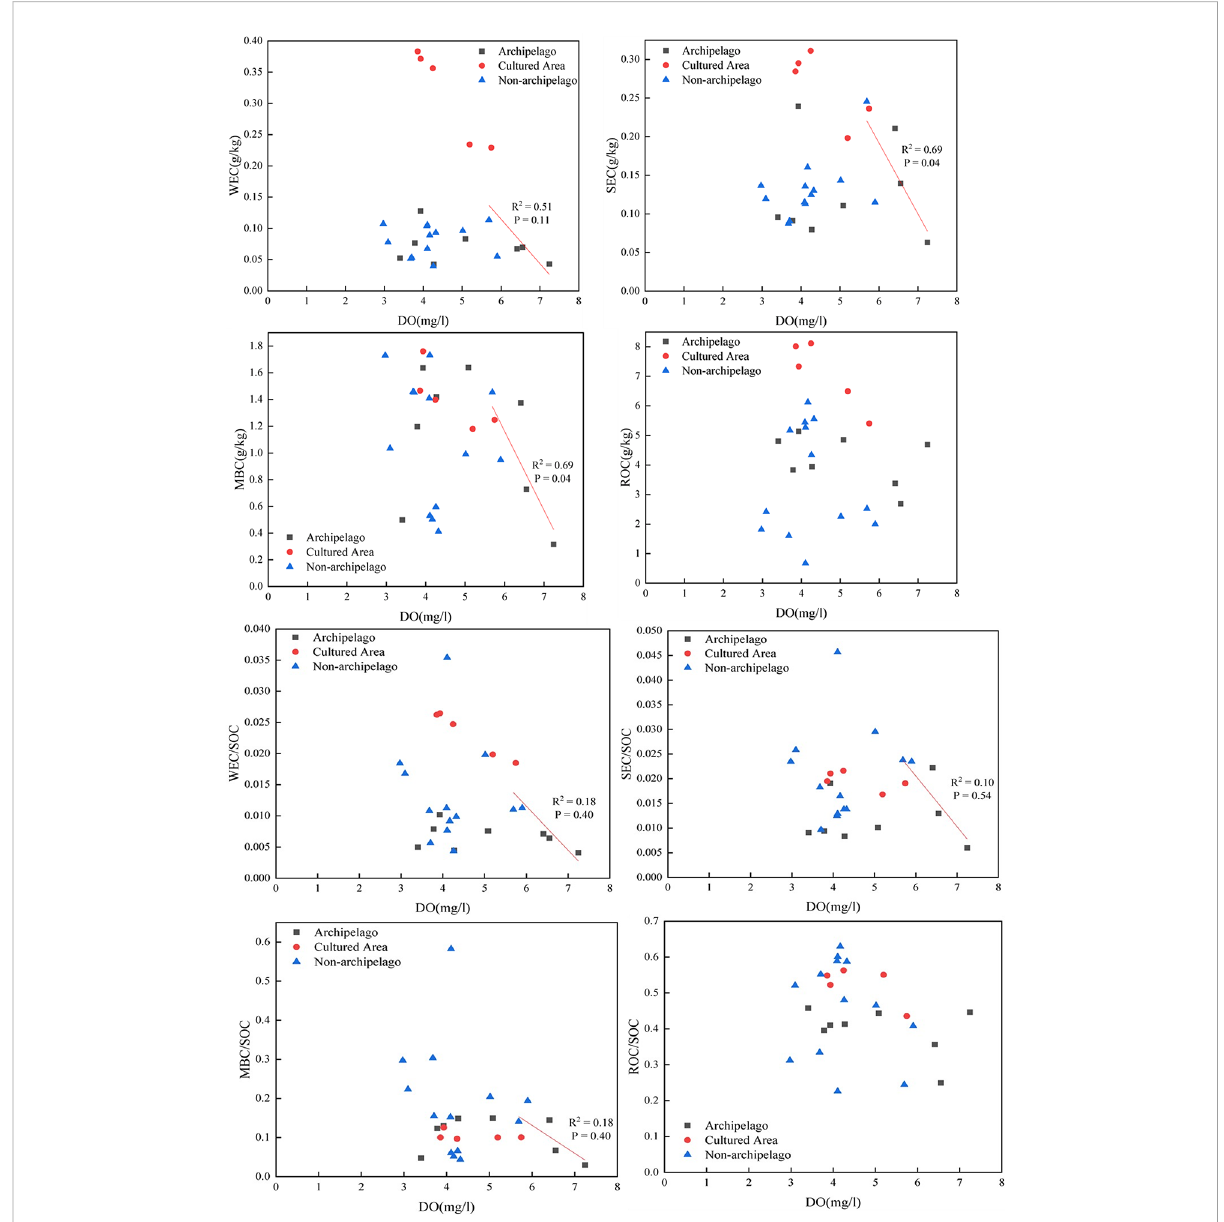
FIGURE 6 Relationship between various carbon fractions in the surface sediments and dissolved oxygen in the near-bottom waters. Gray and dashed arrows indicate the negative relation under high DO background (DO over 5.5